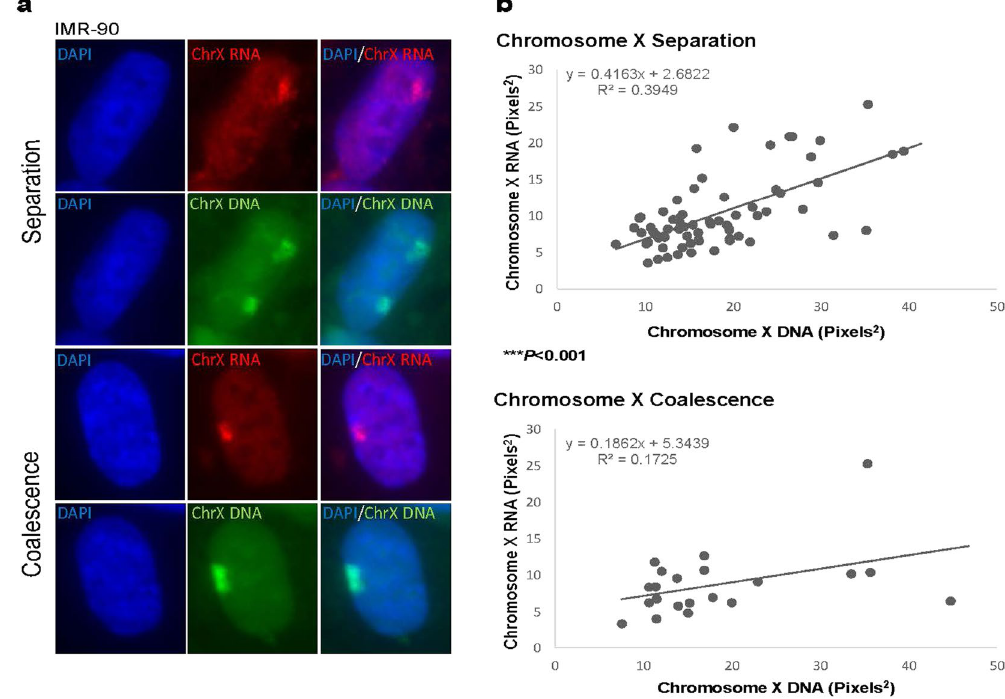
Figure 5. Total chromosome X expression is reduced during X coalescence. ( a ) Single z-section of human IMR- 90 nuclei (blue) with chromosome X RNA (red) and chromosome X DNA (green) labeled during X separation (upper two panels) and coalescence (lower two panels). ( b ) Maximum intensity projection area measurements of total chromosome X RNA and total chromosome X DNA, each data point represents measurements from one nucleus. A total of 70 nuclei during X separation and 30 nuclei during X coalescence were analyzed. * P < 0.05, ** P < 0.01, *** P < 0.001, Welch 2 sample t